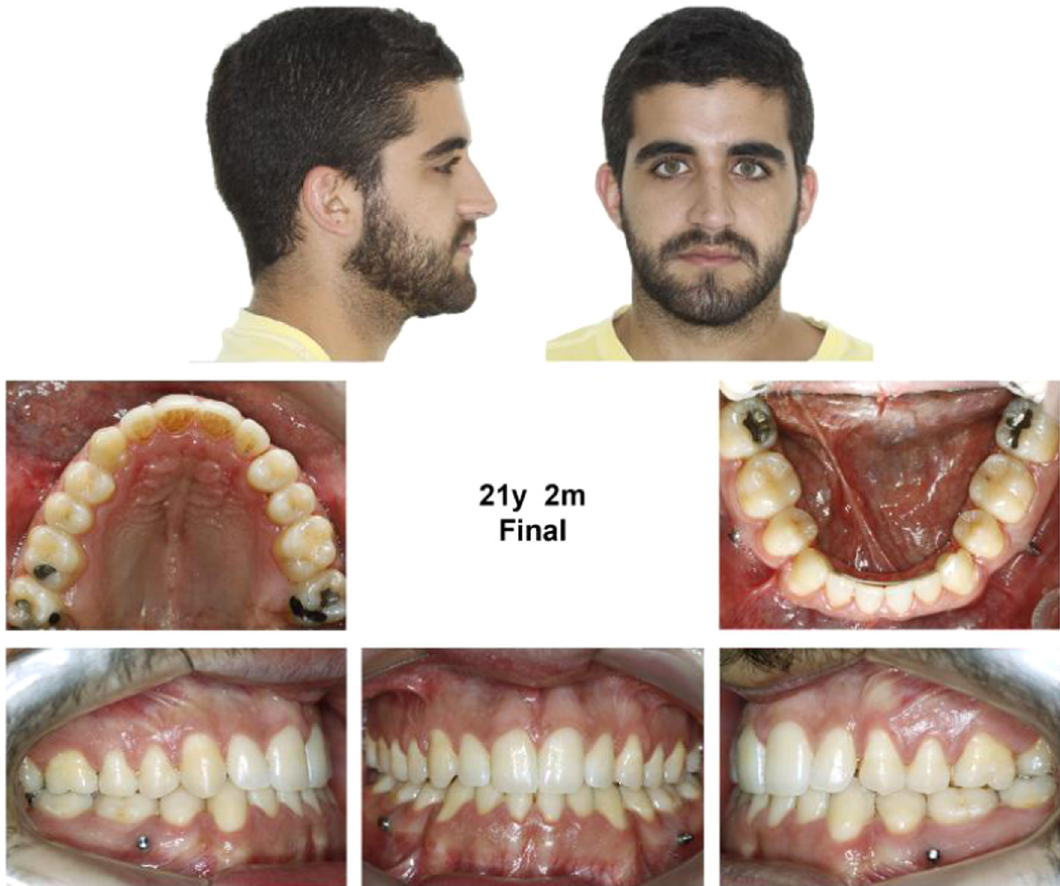
Figure 3. Extra- and intra-oral posttreatment